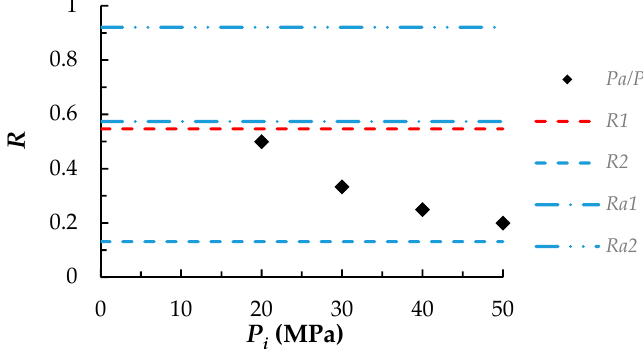
Figure 10. Distribution of pressure ratio under different inlet pressures at constant ambient pressure of 10 MPa.